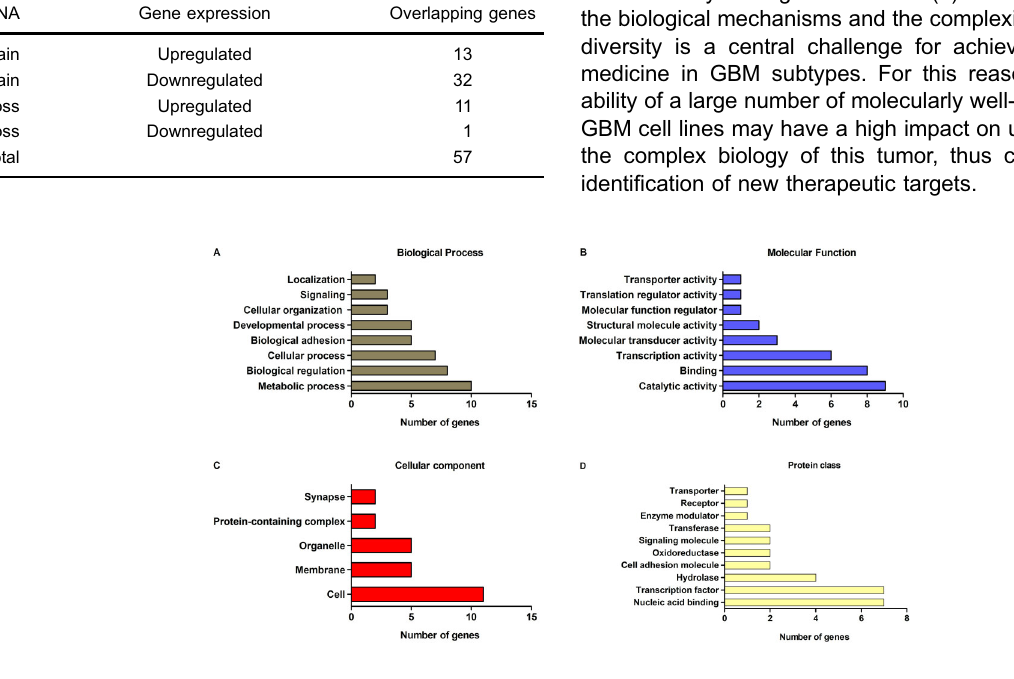
Figure 6. Functional classi fi cation of integrated differentially expressed genes (DEGs) copy number alterations (CNAs) data from AHOL1 cell line using Gene Ontology (GO) analysis. Bar graphs show four independent GO information categories: ( A ) Biological processes, ( B ) Molecular functions, ( C ) Cellular components, and ( D ) Protein classes. The Y-axis represents the number of genes of integrated DEGs-CNAs data and the X-axis shows the GO terms for each category (P o 0.05).